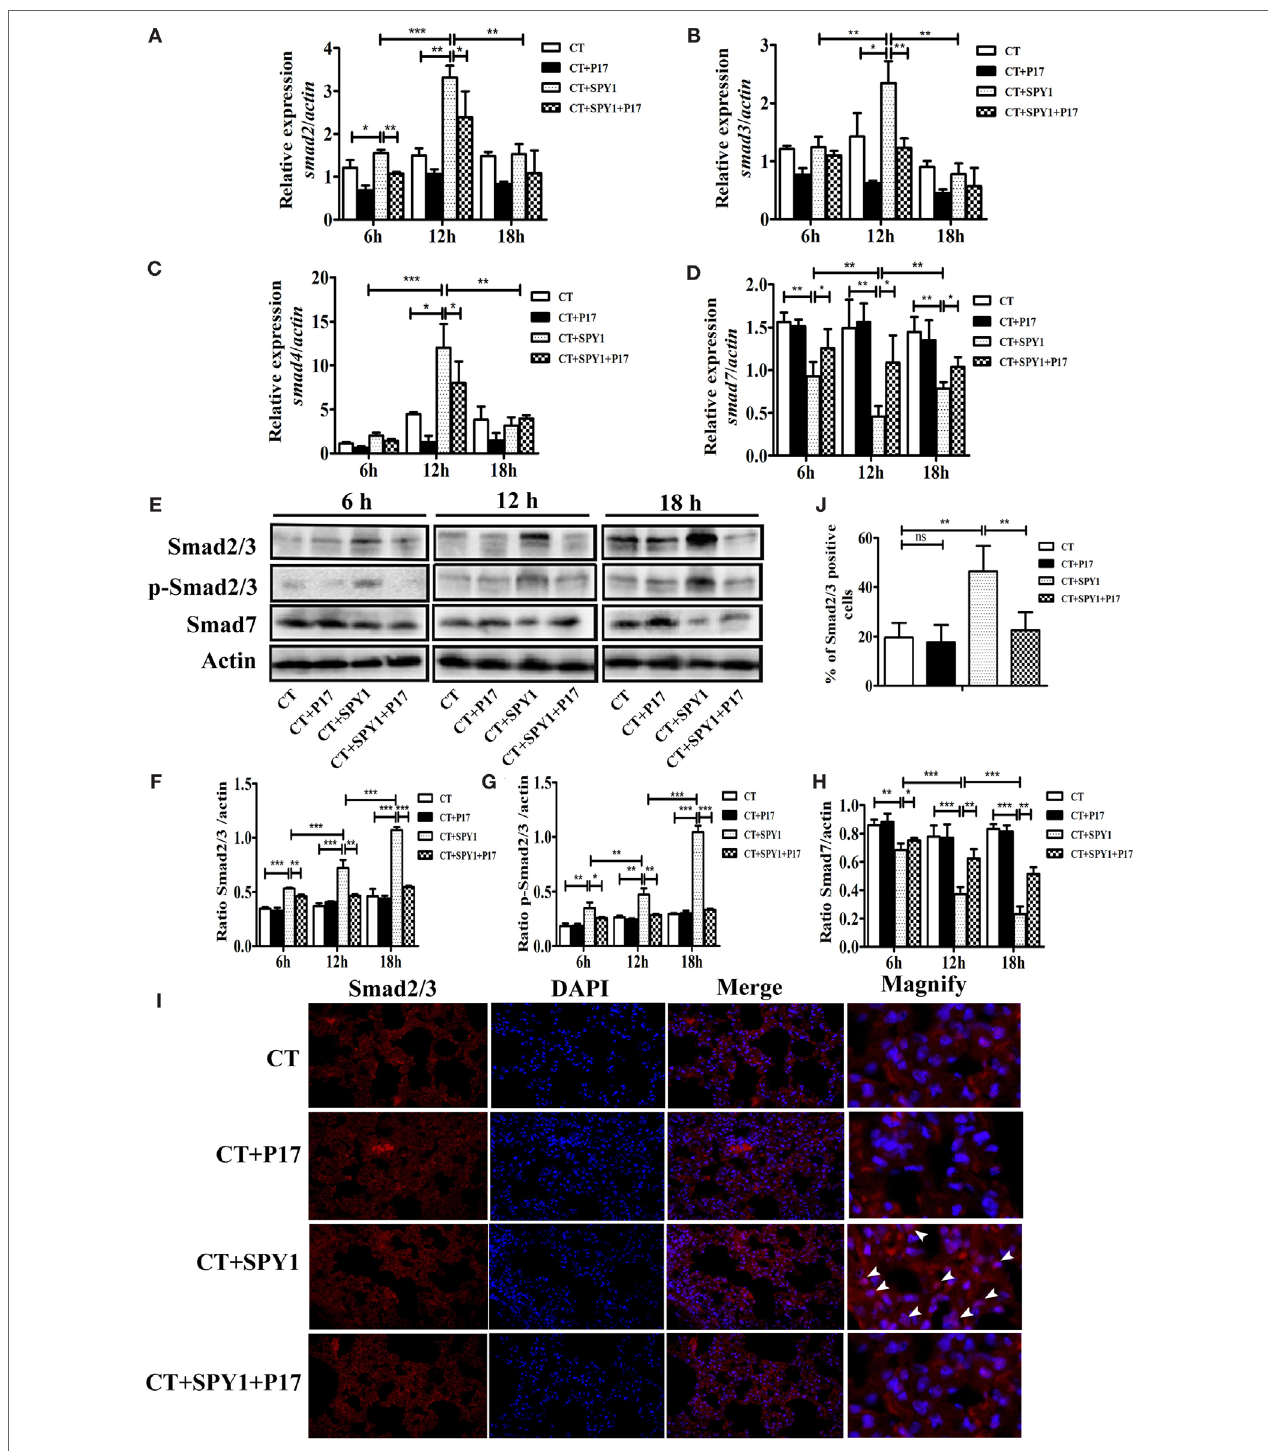
FigUre 6 | Transforming growth factor β (TGF- β )1-Smad2/3 signaling participates in generation of SPY1-specific regulatory T cells (Tregs). Mice were intranasal challenged with pneumococcal strain 19F on day 7 after the last immunization, and the lungs were aseptically removed at 6, 12, and 18 h post-infection. (a–D) Expression of smad2 , smad3 , smad4 , and smad7 in lungs were analyzed by quantitative real-time PCR. The productions of Smad2/3, phosphor-Smad2/3, and Smad7 in lungs were, respectively, determined by western blot (e) and the related band intensities were shown in histograms (F–h) . (i) The expression of Smad2/3 in lungs at 24 h post-infection was examined by immunofluorescence assay with anti-Smad2/3 antibody. Lung sections were examined under light microscopy at magnification 400 × . (J) Statistical analysis of the percentages of lung cells with positive Smad2/3 expression was performed by counting 100 cells per slide (three mice per group). Data were shown as the mean ± SD from three independent experiments. * p < 0.05; ** p < 0.01; *** p <